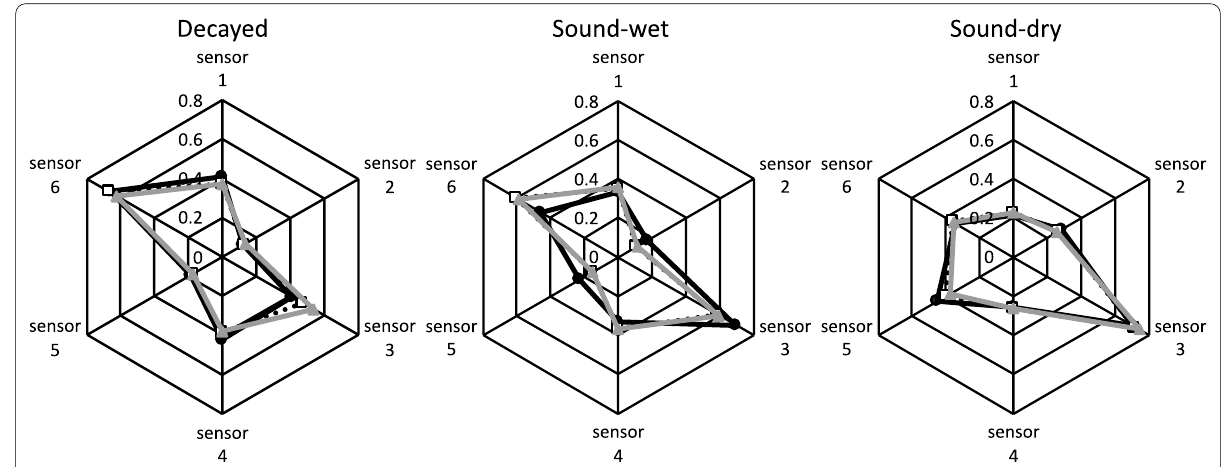
Fig. 5 Example of the normalized sensor response patterns (FP on sugi 20 weeks). Each line shows a pair of test